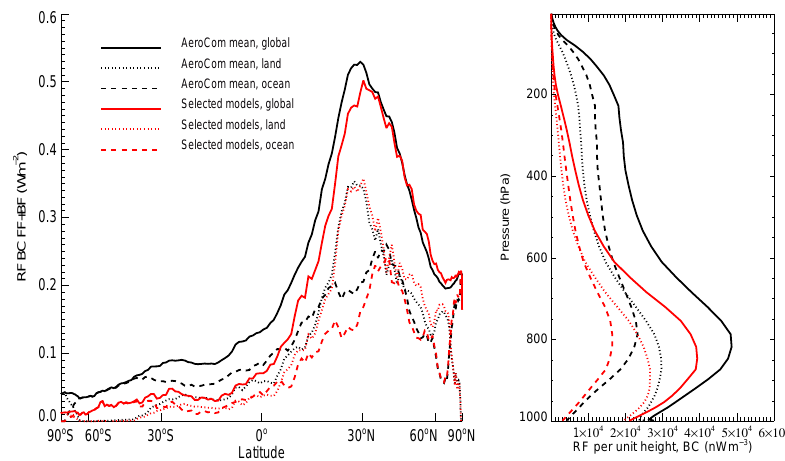
Figure 5. Zonal mean and altitude forcing profiles for AeroCom Phase II models. (a) BC FF + BF forcing, zonal mean, for all 13 models in the present study (black, solid), and the three models selected based on RMSE and correlation versus HIPPO (red, solid). Dotted lines show only forcing over land, dashed show forcing over ocean. (b) As a , except total BC (FF + BF + BB) forcing, and global, annual mean vertical profile. Forcing is shown per altitude metre (unit Wm − 3 ) , to avoid dependence on model vertical